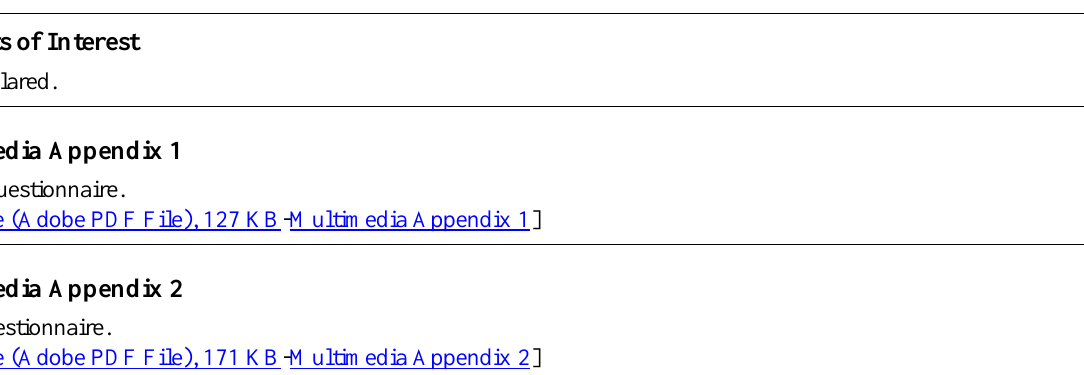
Table S1: Demographics of participants.